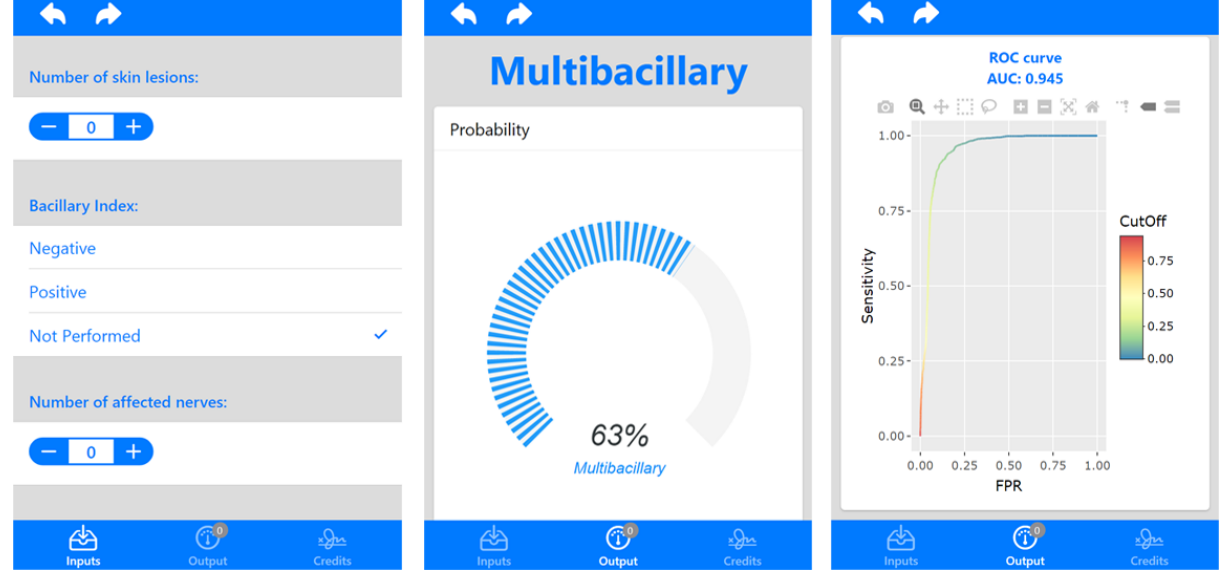
A good model must enhance the TPR and decrease the